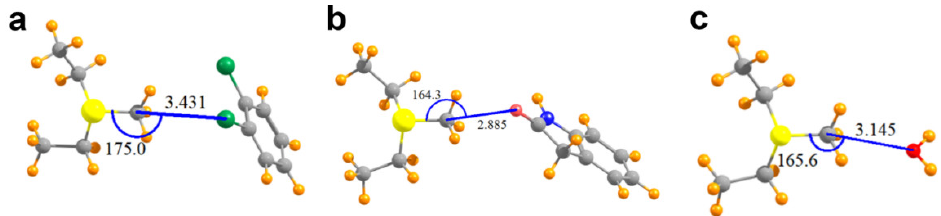
Figure 3. Molecular structures of the models used to computationally analyze AdoMet methyl tetrel bonding in SET domain KMTs. ( a ) Model of MeS + (Et) 2 and dichlorobenzene in the SMYD2 structure; ( b ) MeS + (Et) 2 and oxindole in the SMYD3 structure; ( c ) MeS + (Et) 2 and a water molecule bound in the active site of G9A. Values for the tetrel bond distances and angles are reported in Angstrom and degrees, respectively.